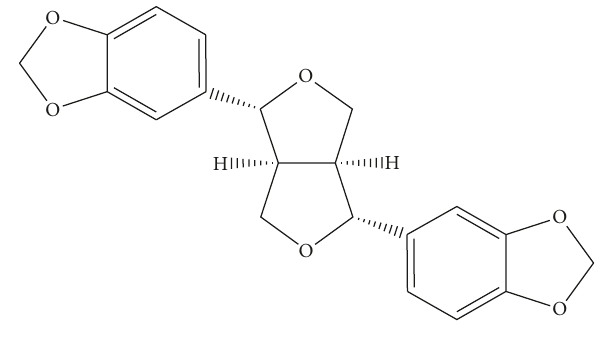
Figure 2: Structure of